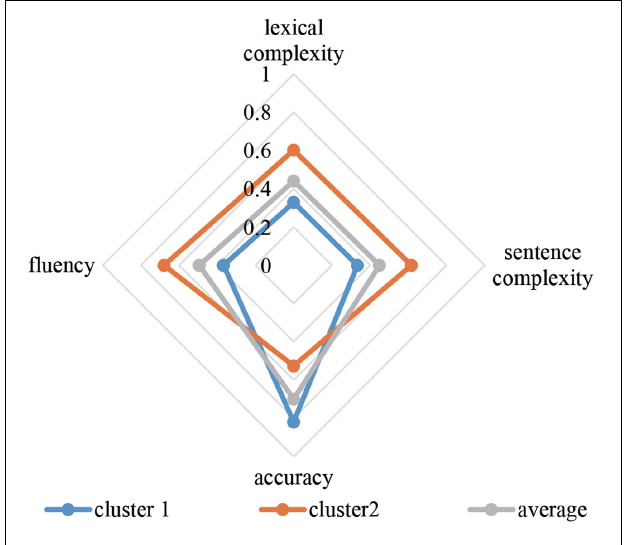
FIGURE 1 | Cluster centers in time